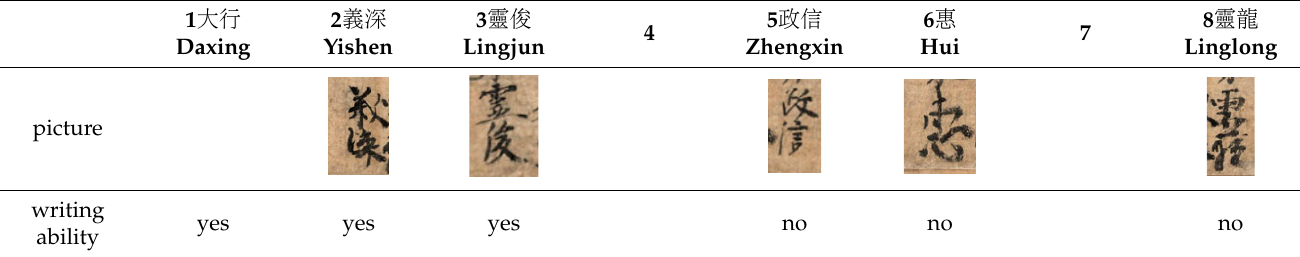
Table 3. Calligraphy of monks of Lingtu Monastery in 905.